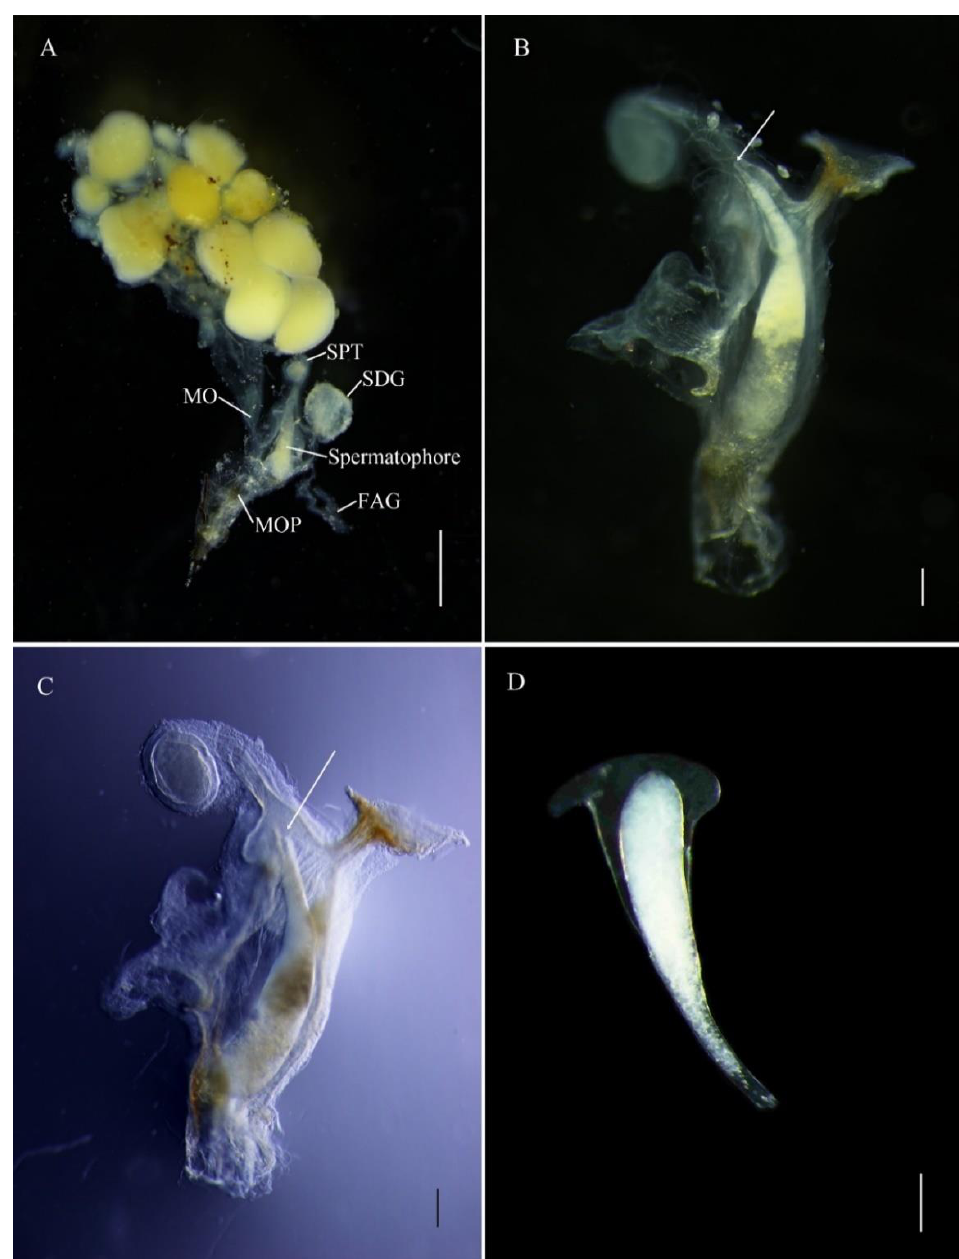
Figure 4. Transfer of male spermatophore to bursa copulatrix of female Emeia pseudosauteri at 15 min after copulation. ( A ) Female reproductive system with male spermatophore. ( B , C ) White arrows showing tip of spermatophore pointed to spermatheca. ( D ) Intact spermatophore. Figure legend: FAG, female accessory gland; MO, median oviduct; MOP, median oviduct plate; SDG, spermatophore-digesting gland; Spermatophore, male spermatophore; SPT, spermatheca. Scale bars for ( A – C ): 0.5 mm, ( D ): 0.2 mm.